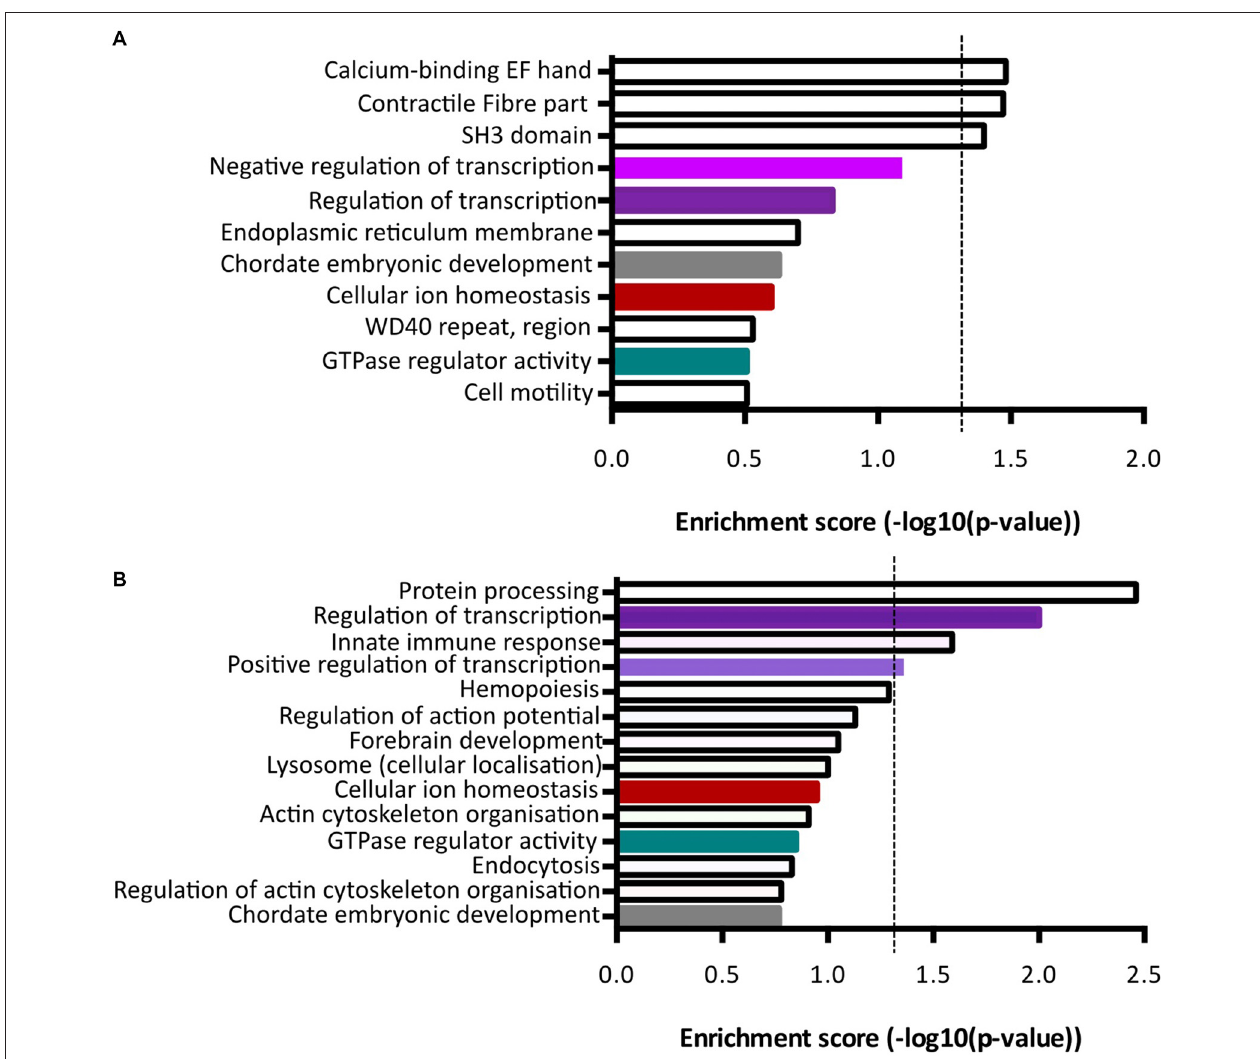
FIGURE 5 | Term enrichment analyses of Fezf2+ve or Fezf2 − ve IT-PN enriched genes. Genes that were enriched in Fezf2+ve and Fezf2 − ve IT-PNs were analyzed separately for term enrichment (A) Fezf2+ve IT-PN enriched genes and (B) Fezf2 − ve IT-PN enriched genes. The red dashed line indicates the significance cut off point ( ≥ 1.3), which is equivalent to p -value ≤ 0.05. Clusters common to both IT-PN types are color-coded accordingly. Shades of purple indicate clusters that all have a common role in